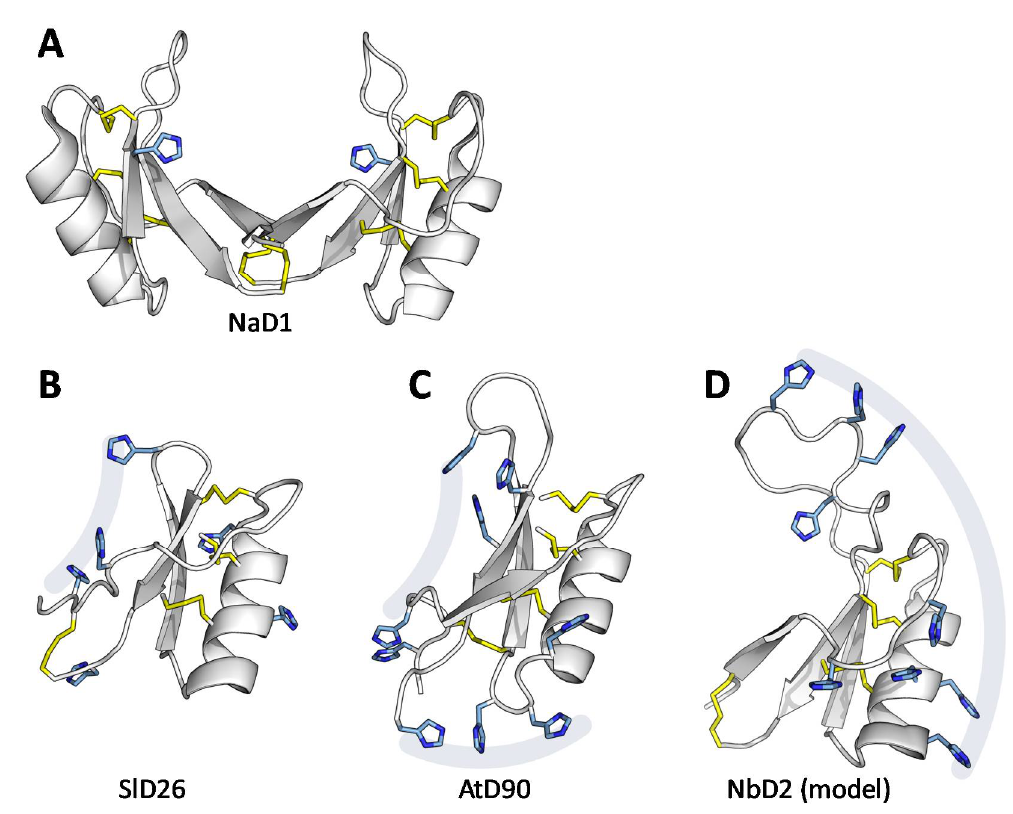
Figure 4. Histidine side-chain orientation. Defensins are shown with disulfides in yellow and histidines in blue (with their nitrogen atoms in dark blue). ( A ) The NaD1 dimer (from PDB:4CQK). ( B ) SlD26, ( C ) AtD90, ( D ) a homology model of NbD2. For flexibility of histidine sidechains see Figure S5).